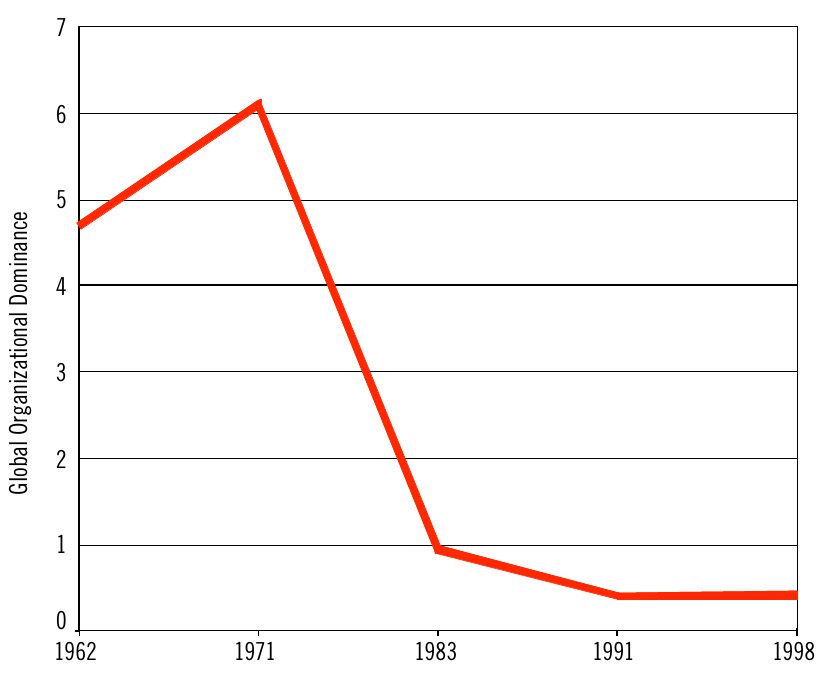
Table 3 – Countries Dominated by US Subsidiaries 1971 (IND